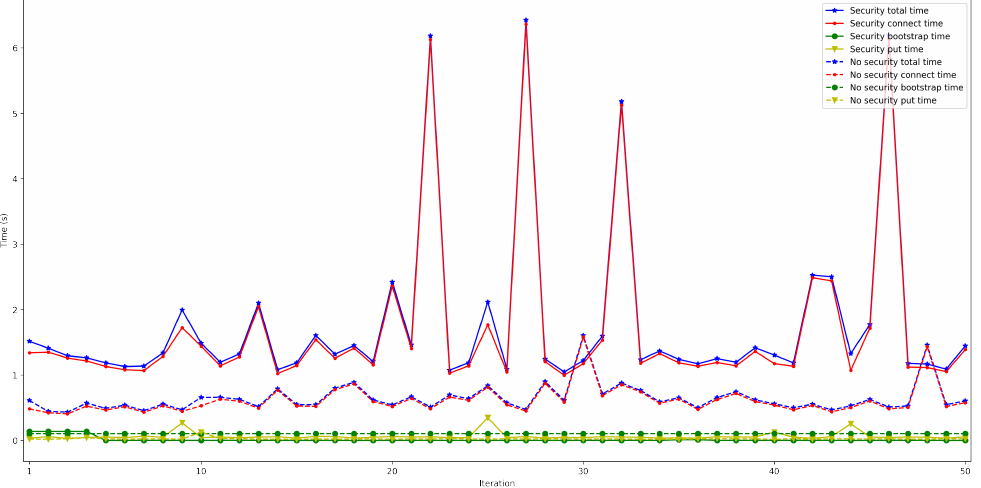
Figure 22. Latency when enabling/disabling TLS 1.3 for 50 peers connected to the bootstrap node.